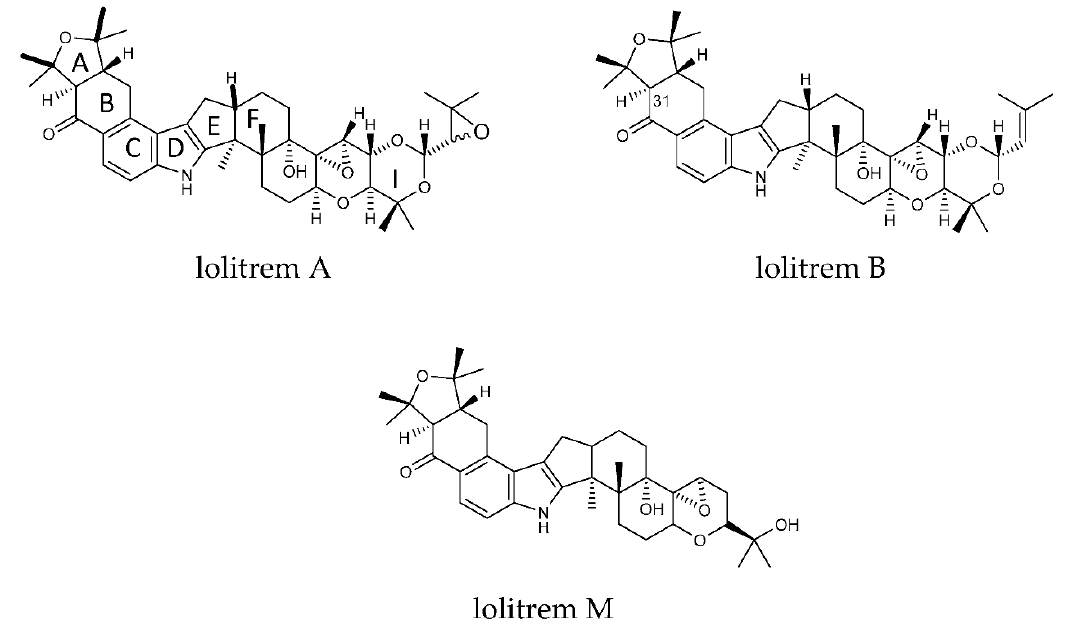
Figure 1. Structures of lolitrem A, B and M.